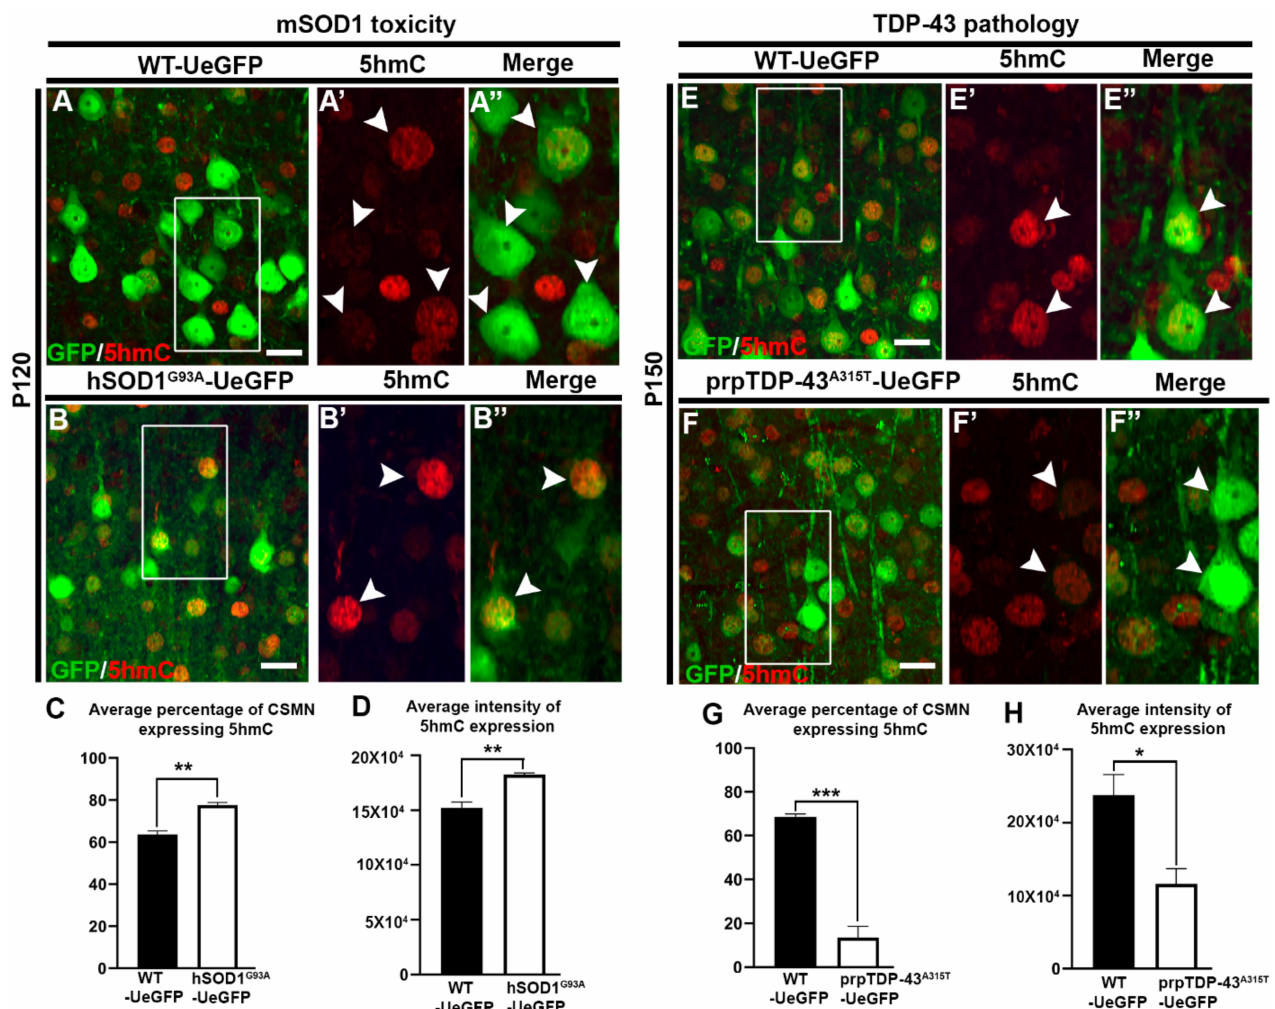
Figure 2. CSMN that are diseased owing to mSOD1 toxicity, and TDP-43 pathology display differential expression of 5-hydroxymethylcytosine (5hmC). ( A ) Representative image of layer V of motor cortex from WT-UeGFP mouse at P120 showing GFP-labelled CSMN and 5hmC expression. Box enlarged ( A (cid:48) , A” , arrow heads). ( B ) Representative image of layer V of motor cortex from hSOD1 G93A -UeGFP mouse at P120 showing GFP-labelled CSMN and 5hmC expression. Box enlarged ( B (cid:48) , B” , arrow heads). ( C ) Quantitative analysis of average percentage of CSMN expressing 5hmC in hSOD1 G93A -UeGFP mouse at P120. ( D ) Quantitative analysis of average intensity of 5hmC expression in CSMN of hSOD1 G93A -UeGFP mouse at P120. ( E ) Representative image of layer V of motor cortex from WT-UeGFP mouse at P150 showing GFP-labelled CSMN and 5hmC expression. Box enlarged ( E (cid:48) , E” , arrow heads). ( F ) Representative image of layer V of motor cortex from prp-TDP-43 A315T -UeGFP mouse at P150 showing GFP-labelled CSMN and 5hmC expression. Box enlarged ( F (cid:48) , F” , arrow heads). ( G ) Quantitative analysis of average percentage of CSMN expressing 5hmC in prp-TDP-43 A315T -UeGFP mouse at P150. ( H ) Quantitative analysis of average intensity of 5hmC expression in CSMN of prp-TDP-43 A315T -UeGFP mouse at P150. * p < 0.025, ** p < 0.001, *** p < 0.0005; Scale bar: 20 µ